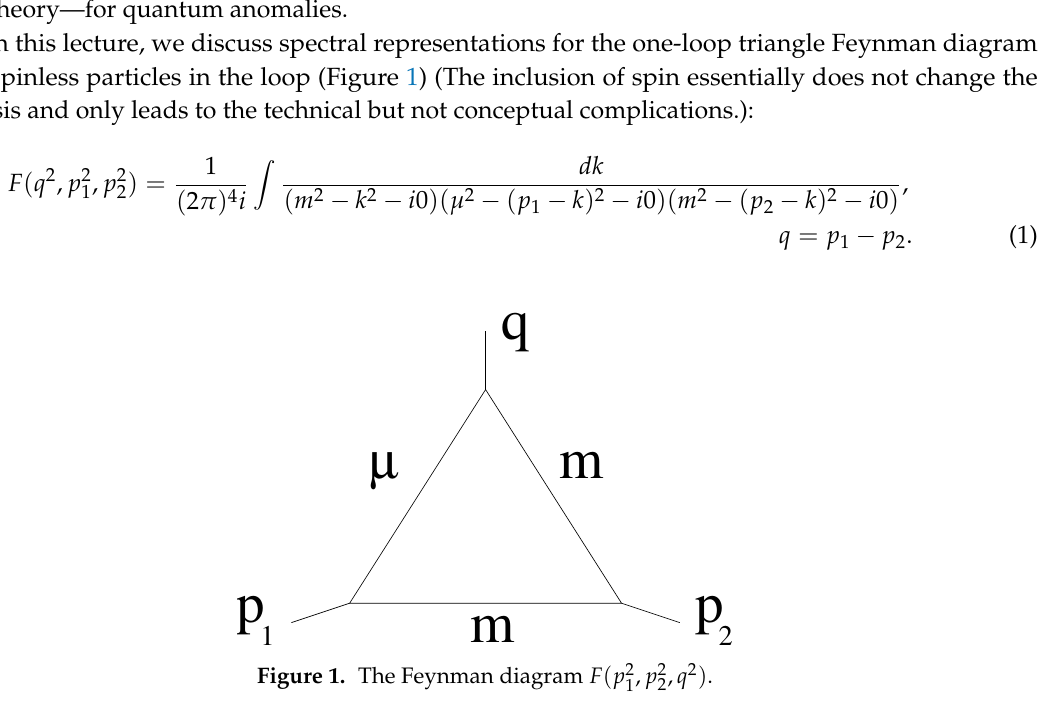
Figure 1. The Feynman diagram F ( p 2